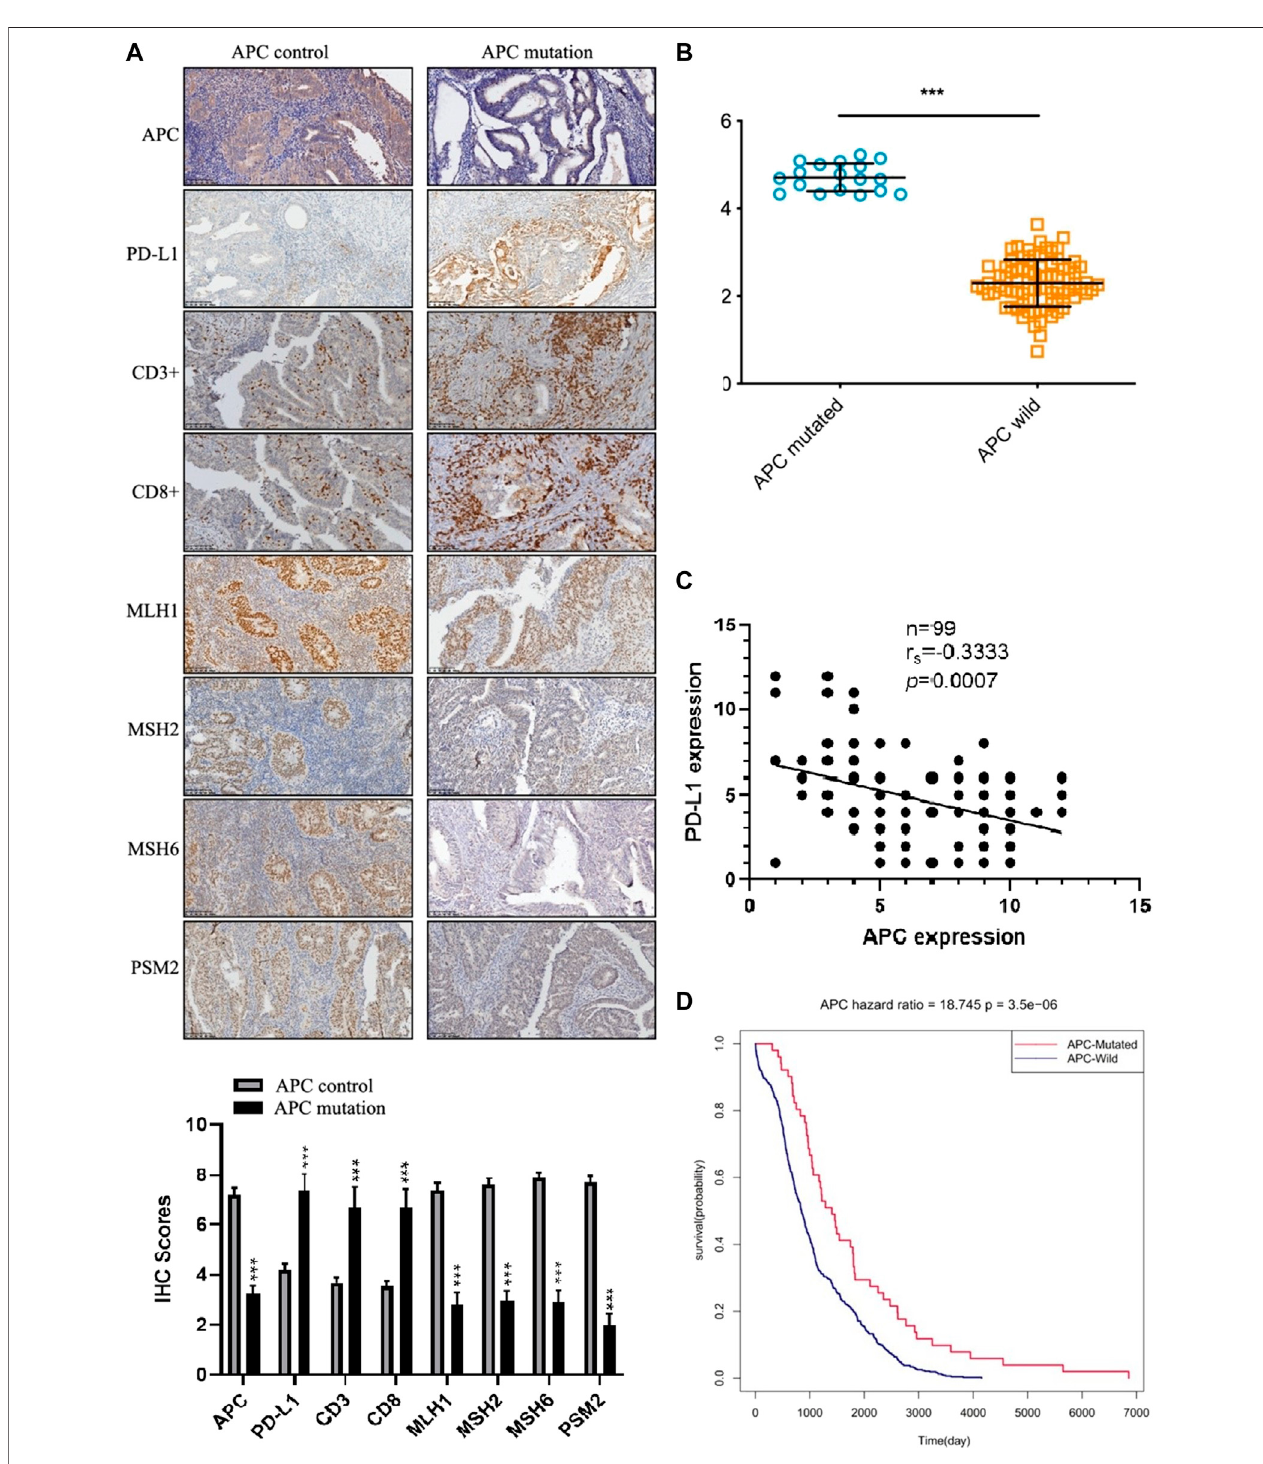
FIGURE 7 | The expression of APC in endometrial cancer. (A) Immunohistochemistry staining of the indicated proteins in APC control samples and APC mutation samples. (B) TheAPCgeneisweaklyexpressedinhumanendometrialcancer( p =6.17624e-27). (C) TheSpearmanrankcorrelationanalysisofthecorrelationbetween the PD-L1 expression and APC expression ( n = 99, p = 0.0007). (D) Prognostic value of the APC expression in endometrial cancer patients from TCGA (Kaplan – Meier was used to estimate the survival rate).